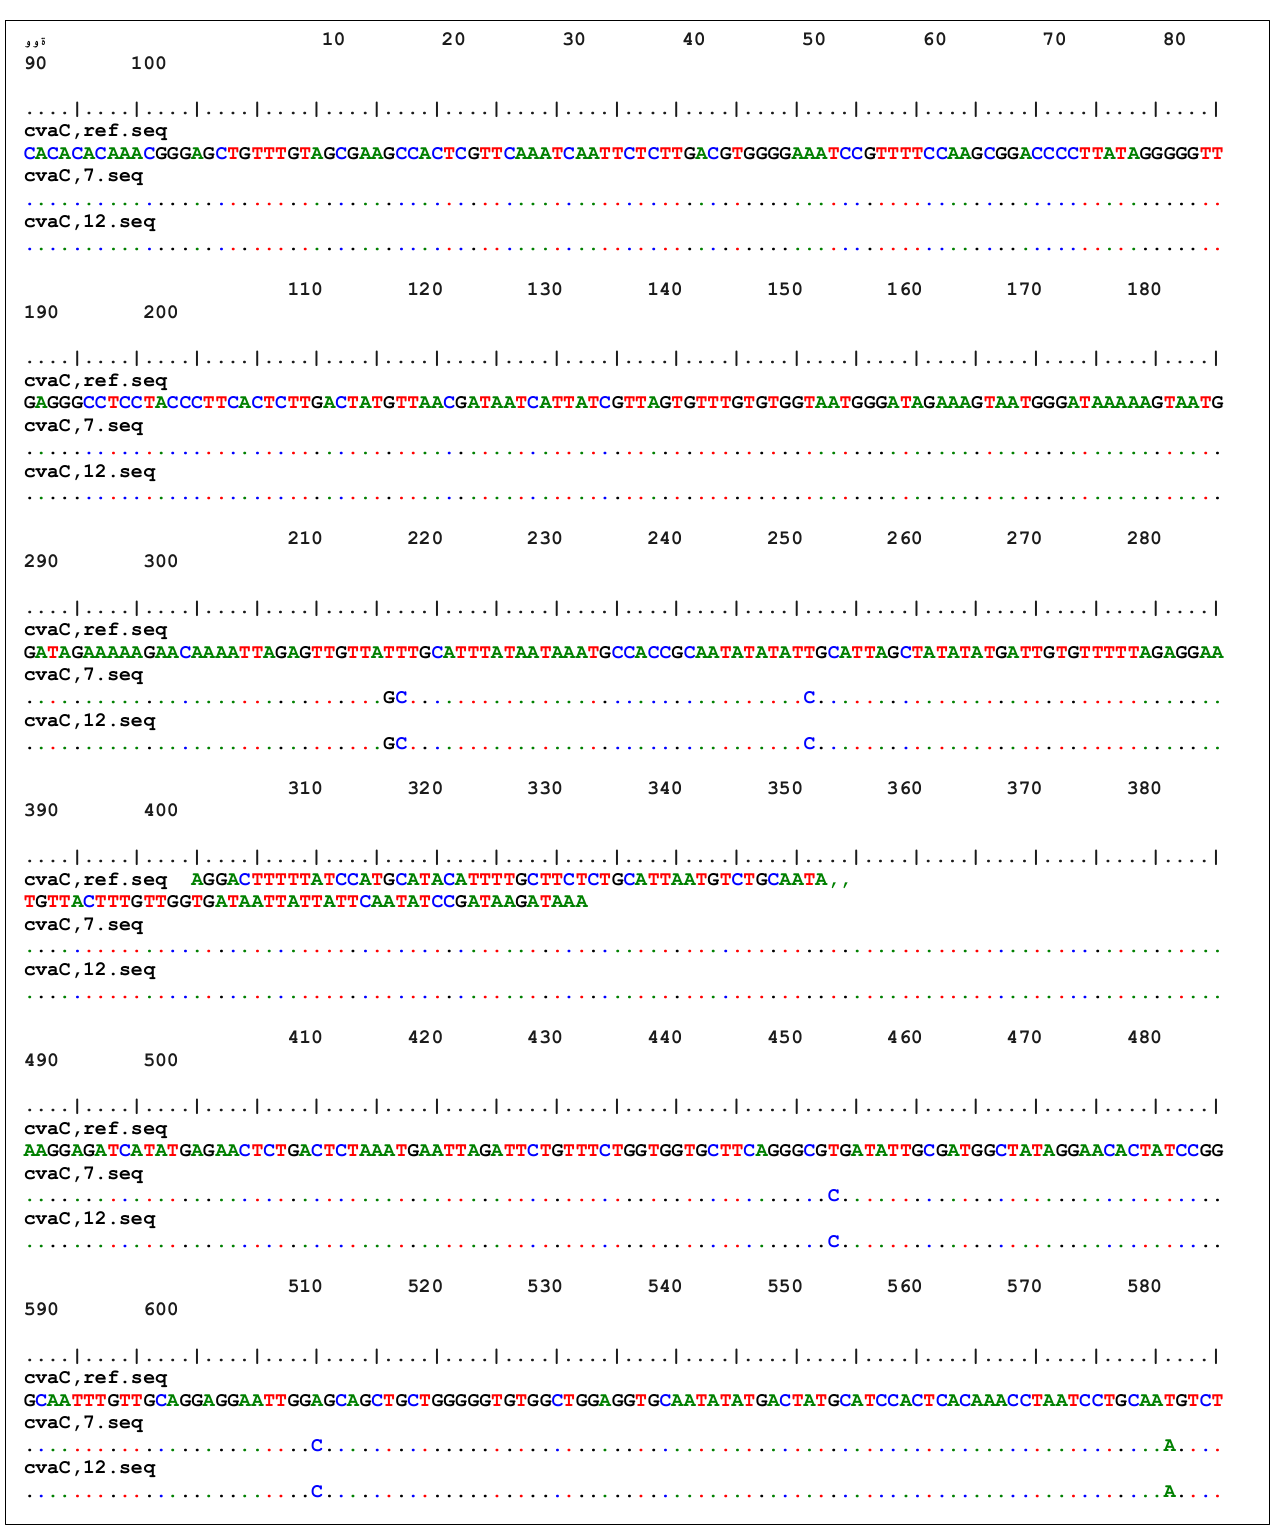
Figure 2: Analysis of the multiple sequences of the reference cvaC gene with two changes in A . baumanii isolates A7 and A12 using the BioEdit Sequence Alignment Editor